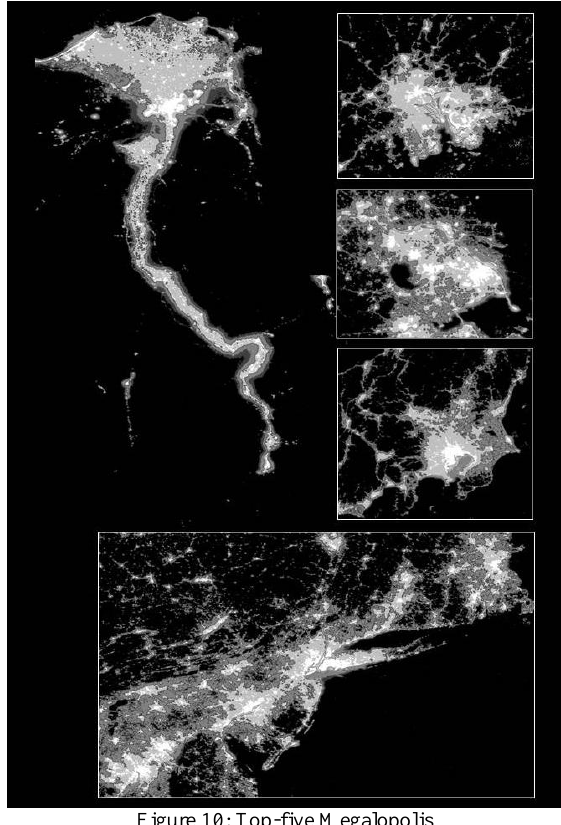
Figure 10: Top-five